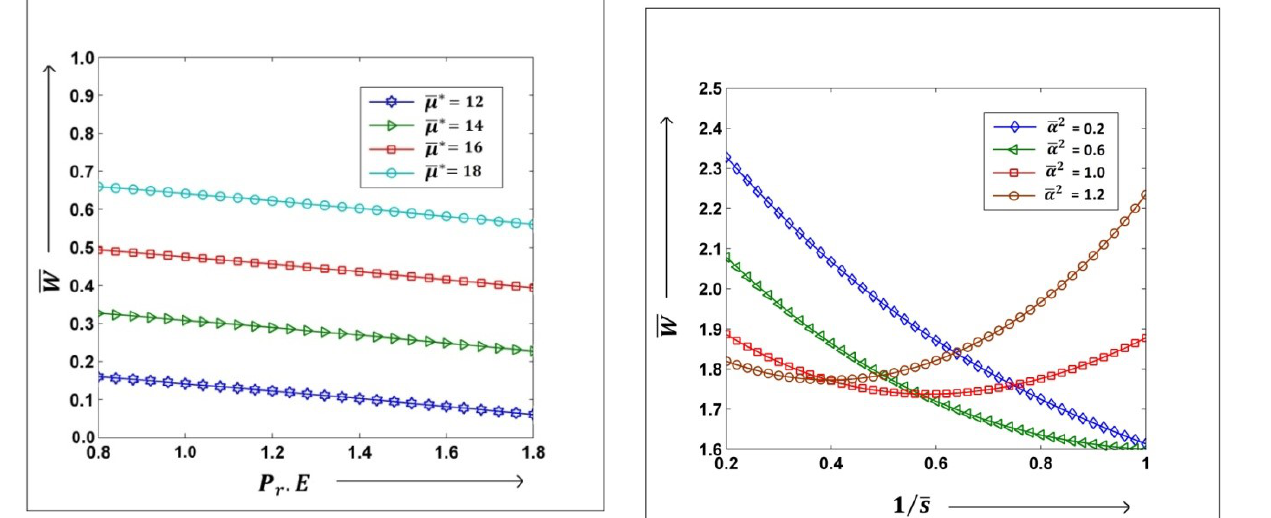
Fig. 12: Lifting force vs. slip parameter for different values of the magnetic parameter at ¯ β = 1.3, ¯ γ 2 = 1.2, P